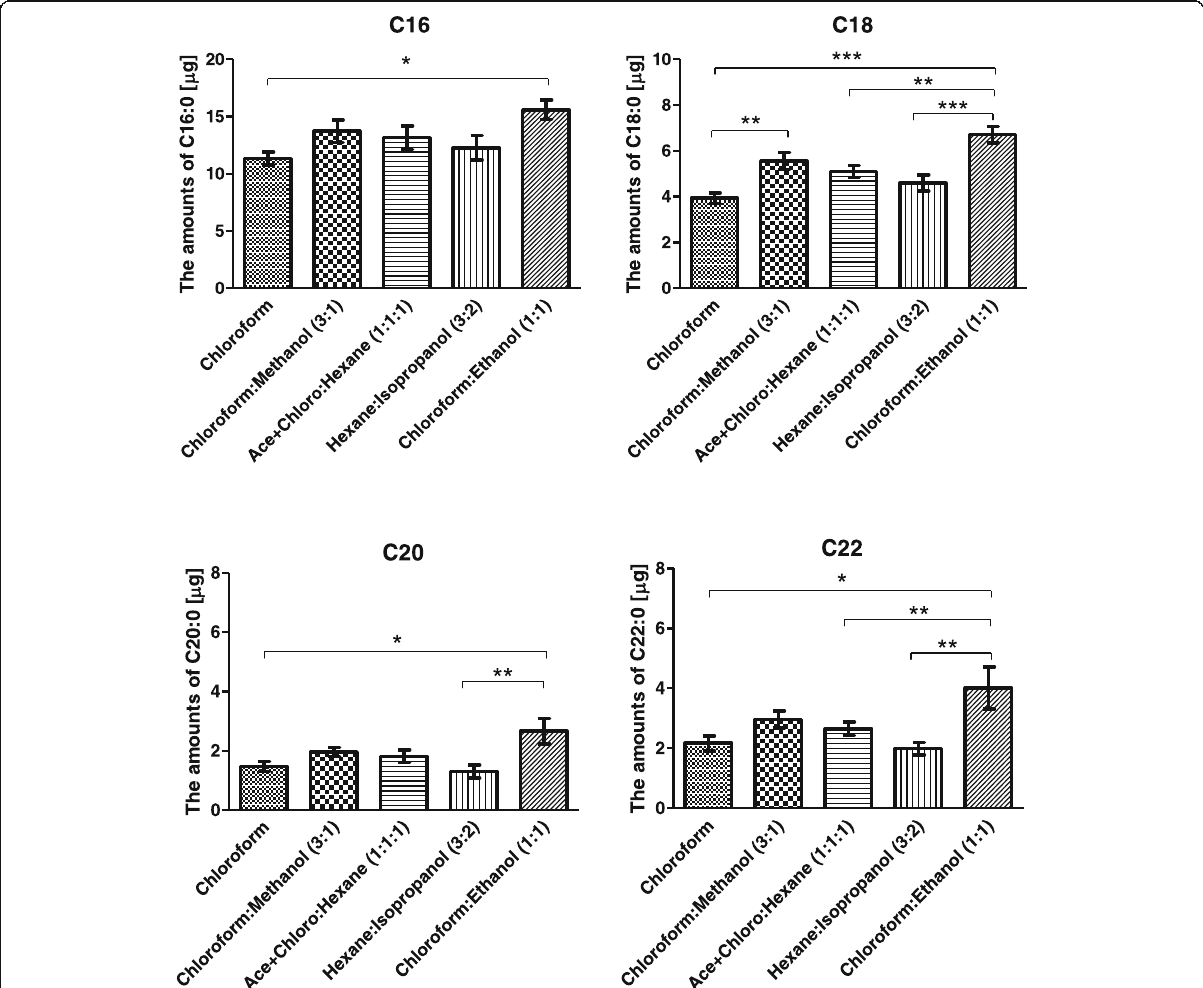
Fig. 7 Total quantity of C16, C18, C20, and C22 by using different organic solvents ( μ g of total fatty acids, n = 10, all donors). Data are represented as means ± SEM. The three asterisks, two asterisks, and one asterisk indicate 0.0001 ≤ p < 0.001, 0.001 ≤ p < 0.01, and 0.01 ≤ p < 0.05, respectively. “ No SD ” means there is no significant